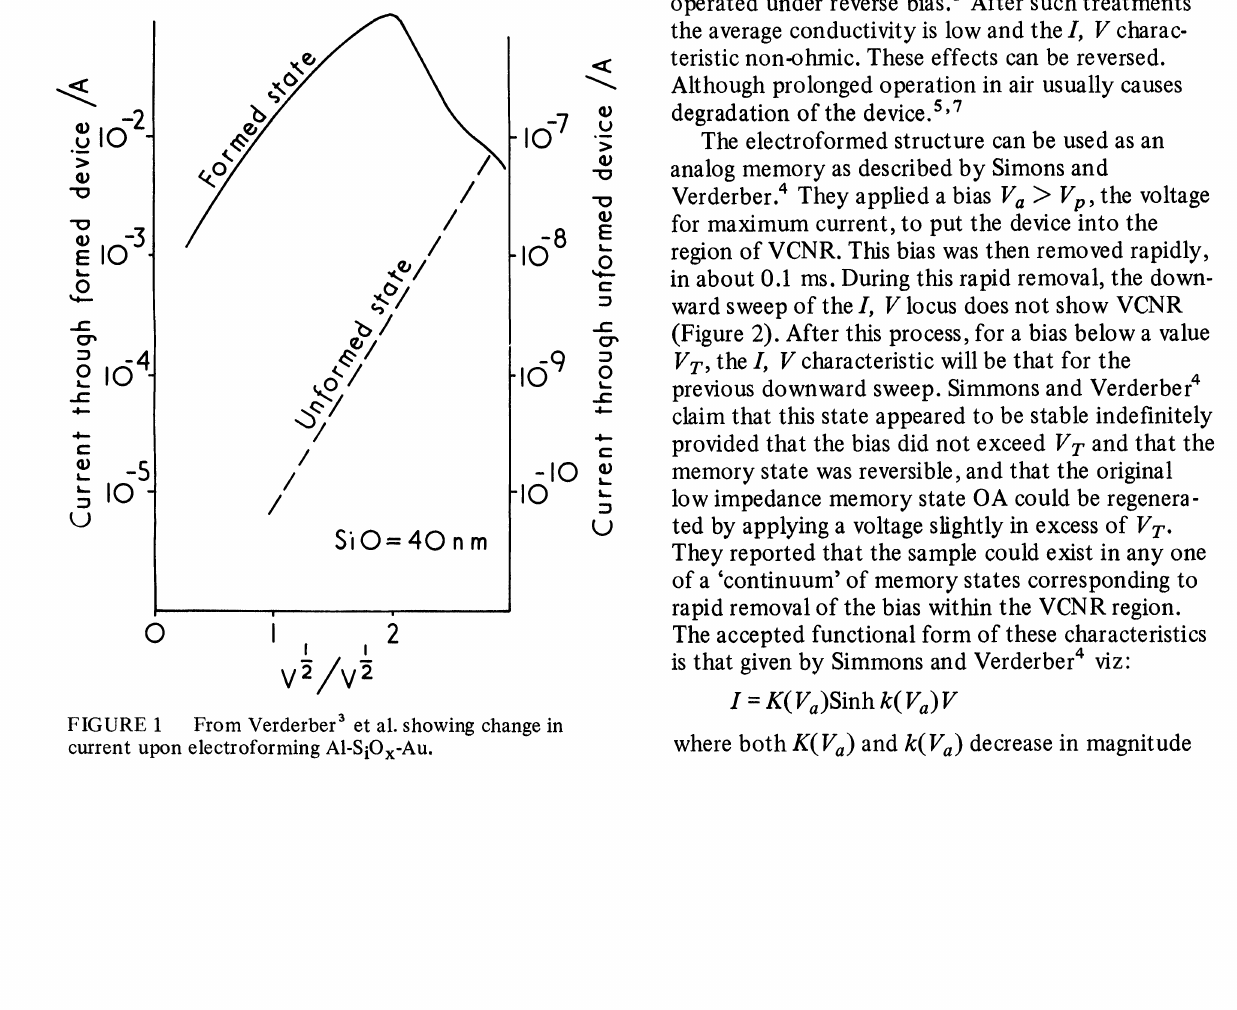
O FIGURE 2 I, V characteristic of formed device and an analog memory state (schematic